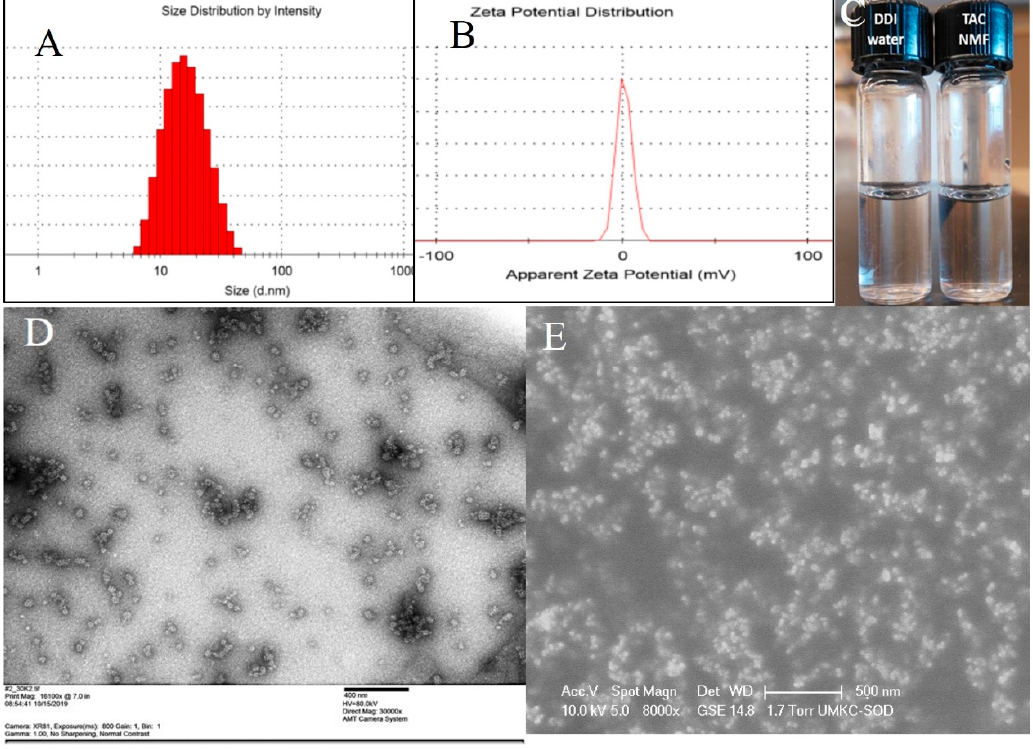
Figure 5. Size distribution of ( A ) Tacrolimus nanomicelles (TAC-NMF) and ( B ) Zeta potential of TAC-NMF, ( C ) Visual comparison of TAC-NMF with DDI water, and ( D ) TEM image of TAC-NMF ( E ) SEM image of TAC-NMF.